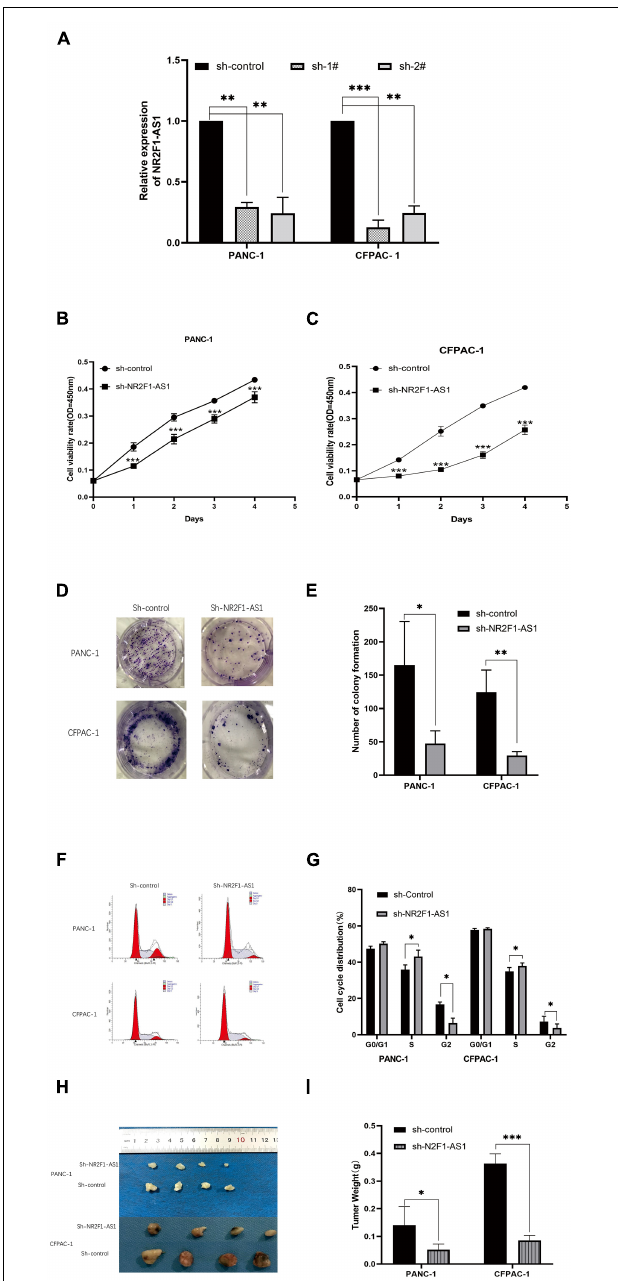
FIGURE 2 | Downregulation of NR2F1-AS1 expression suppresses PDAC cell proliferation and tumor growth in vitro and in vivo . (A) Expression of NR2F1-AS1 in PANC-1 and CFPAC-1 cells transfected with NR2F1-AS1 shRNA. (B,C) Knockdown of NR2F1-AS1 significantly suppressed proliferation in PANC-1 and CFPAC cells compared with the control group. Cell viability was determined by CCK-8 assay. (D,E) Colony forming assays after sh-NR2F1-AS1 transfection in PANC-1 and CFPAC-1 cells. (F,G) Flow cytometry was carried out to examine the cell cycle status of PANC-1 and CFPAC-1 cells after transfection with either sh-NR2F1-AS1 or sh-control. (H,I) Knockdown of NR2F1-AS1T reduces the tumor weight. The nude mice were sacrificed 21 days after the injection, and tumors from the respective groups are shown. (H) Image of the tumors; (I) tumor weight. ∗ p < 0.05, ∗∗ p < 0.01, and ∗∗∗ p <